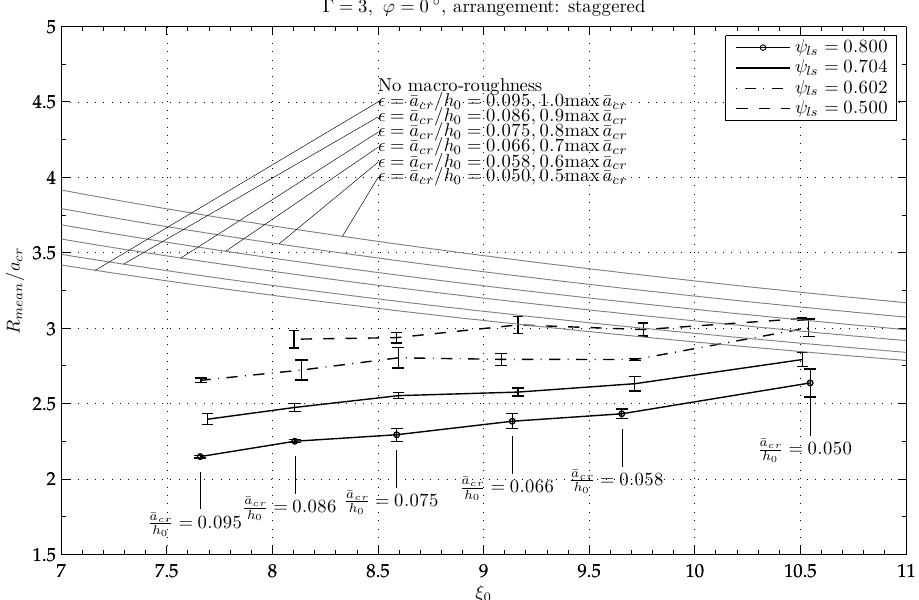
Fig. A2. The relative wave run-up ( R mean /a cr ) as a function of the surf similarity parameter ( ξ 0 ), 0 = 3. The experimental data are plotted according to the individual long-shore obstruction ratio. The error bars indicate the variation of the number of macro-roughness element rows. The grey parallel graphs indicate the relative run-up without the interaction with macro-roughness. The non-linearity of the applied waves is indicated as text which always refers to all error bars in the vertical